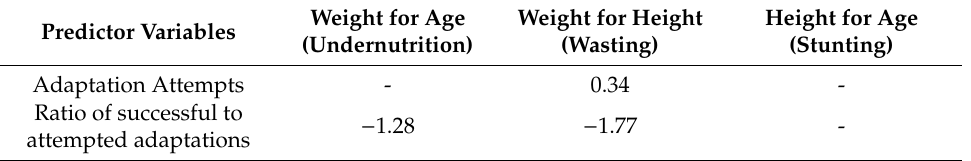
Table 3. Beta estimates for all significant ( p < 0.05) relationships between nutrition z-scores and adaptation. Weight for Age Weight for Height Height for Age Predictor Variables (Undernutrition) (Wasting) (Stunting) Adaptation Attempts - 0.34 - − 1.28 − 1.77